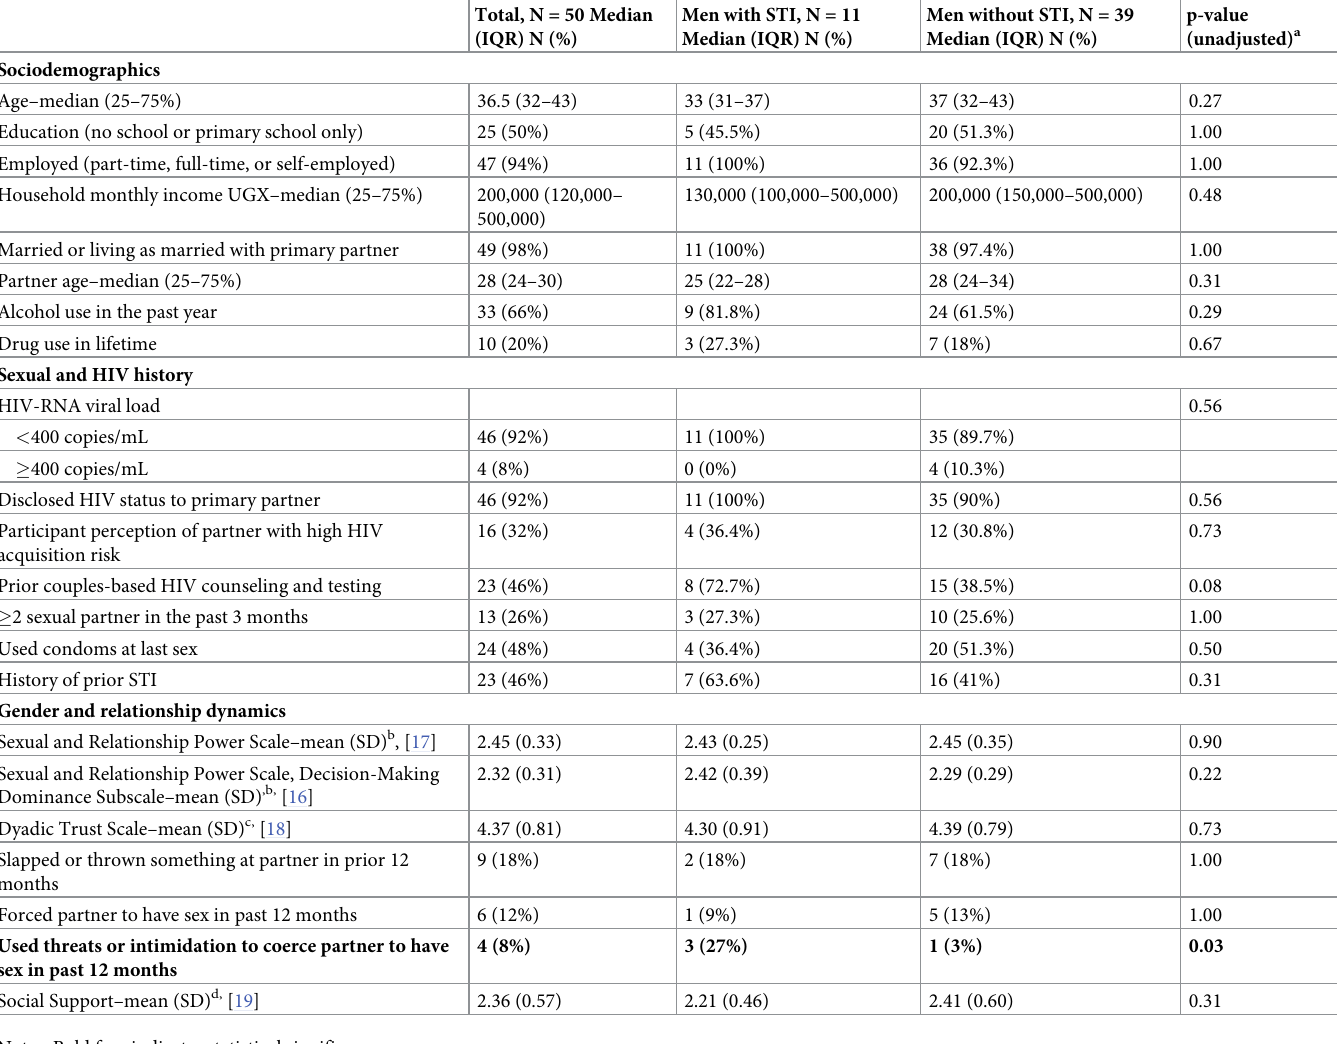
Table 1. Baseline socio-demographic characteristics of men living with HIV seeking safer conception care, by STI status (n =